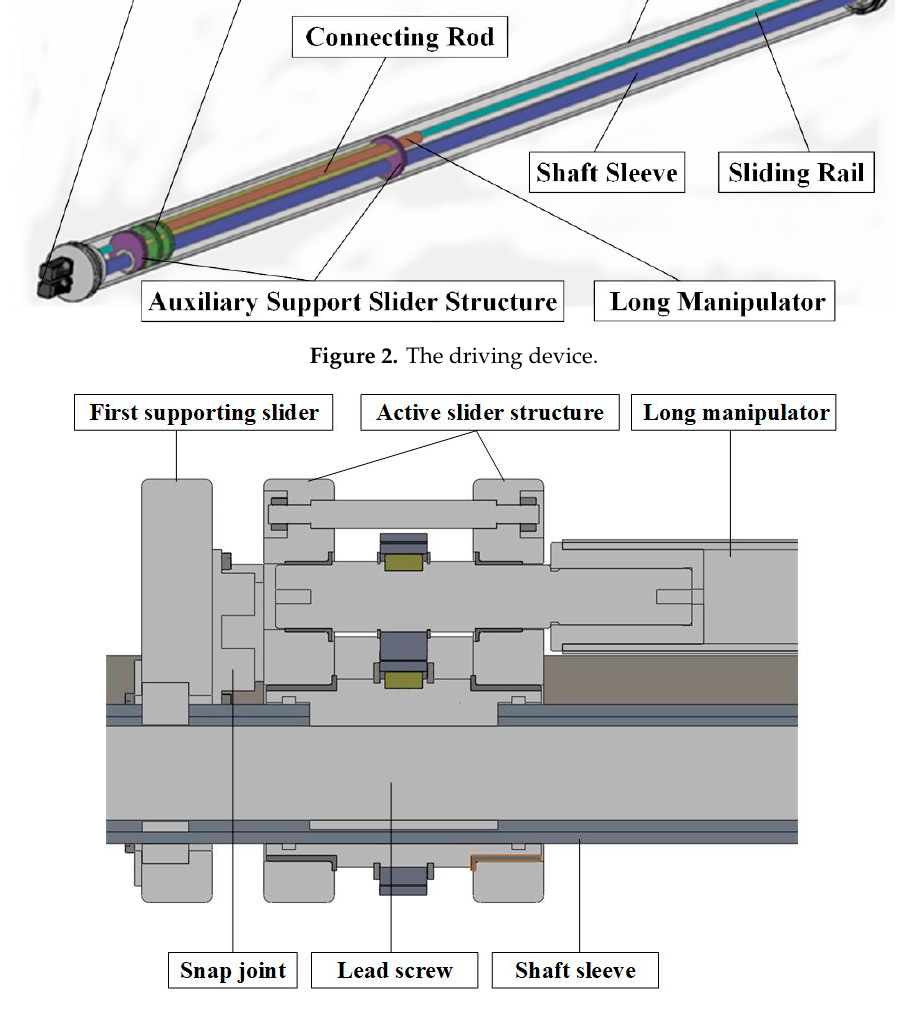
Figure 3. The schematic diagram.